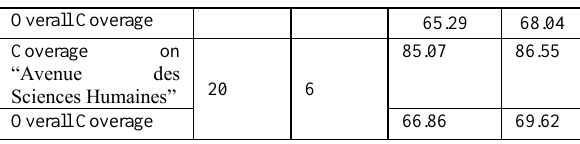
Table 4: Results of increasing number of sensors to cover the region of interest